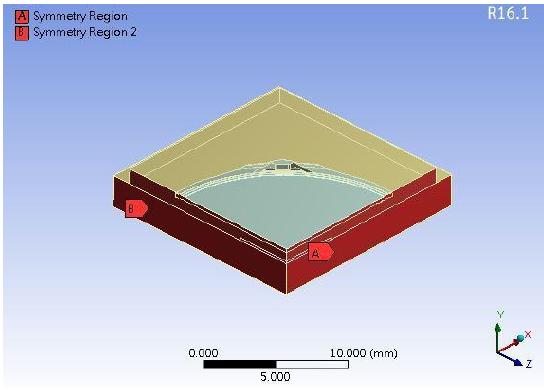
Figure 7. A simplified quarter model for molding simulation.